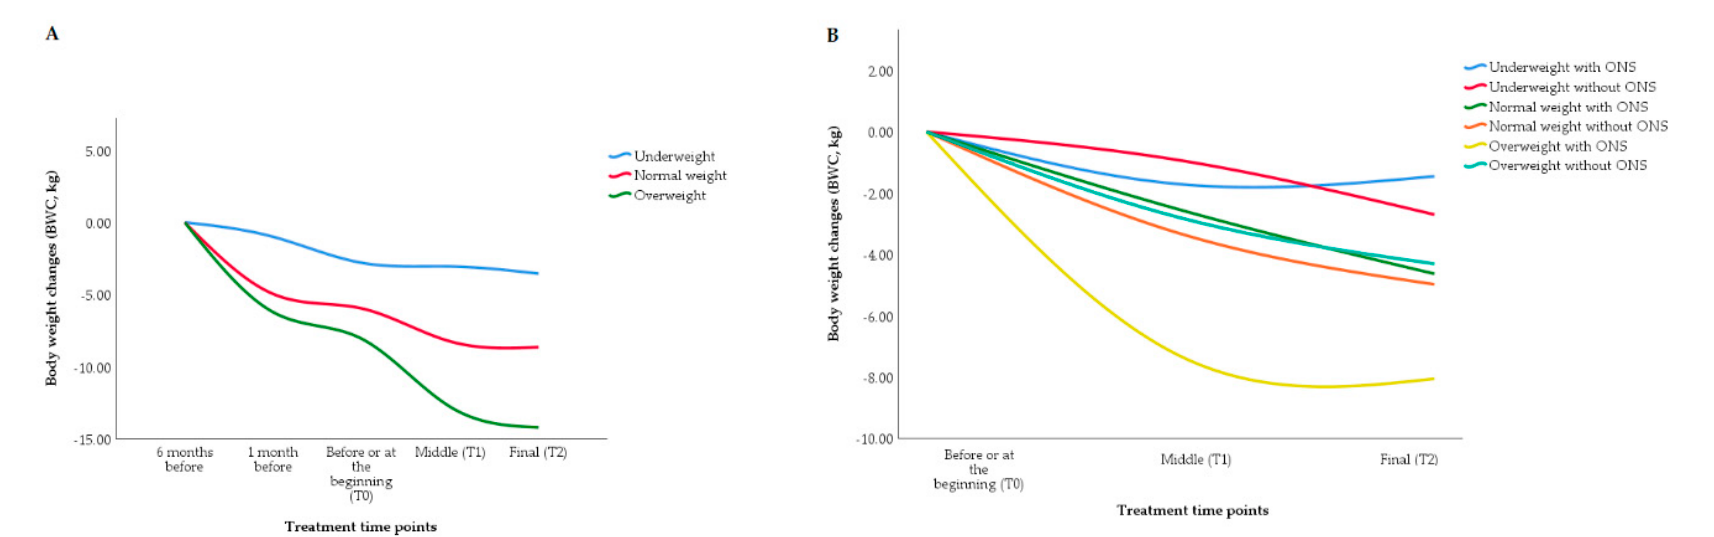
Figure 1. BWC by BMI groups. ( A ) BWC considering 5 time points (two points before treatment and the three treatment time points) for the patients categorized by habitual BMI (kg/m²). ( B ) BWC for the patients considering three time points (the three treatment time points) categorized by T0 BMI (kg/m²) and use or not of ONS. Abbreviations: BWC, body weight changes; BMI, body mass index; ONS, oral nutritional supplementation.